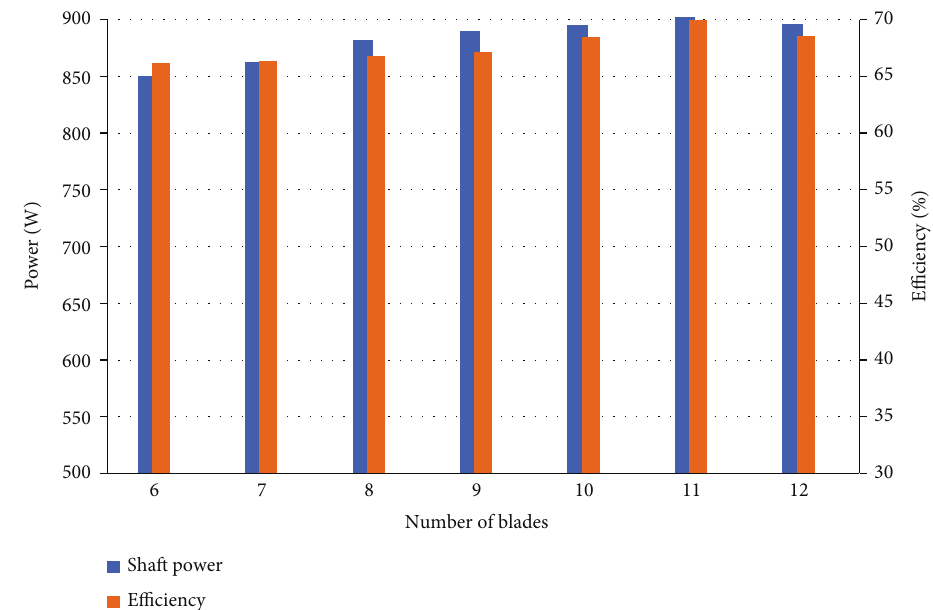
Figure 5: The e ff ect of the number of impeller blades on the PAT performance.